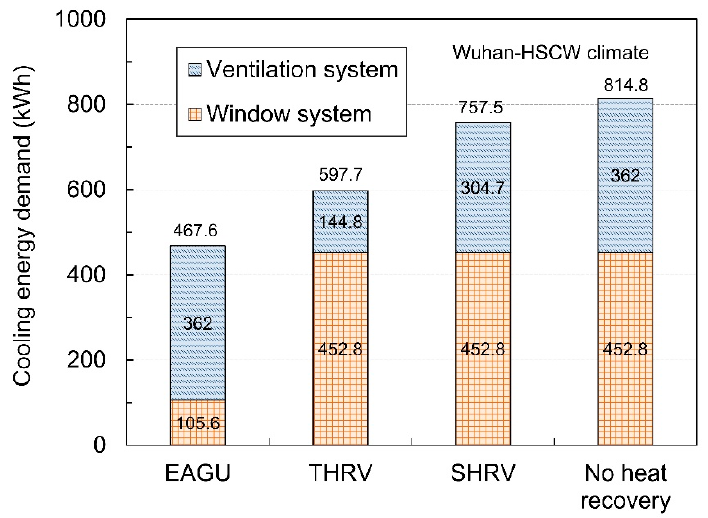
Figure 8. Seasonal total energy demand of the four cases in the cooling season.